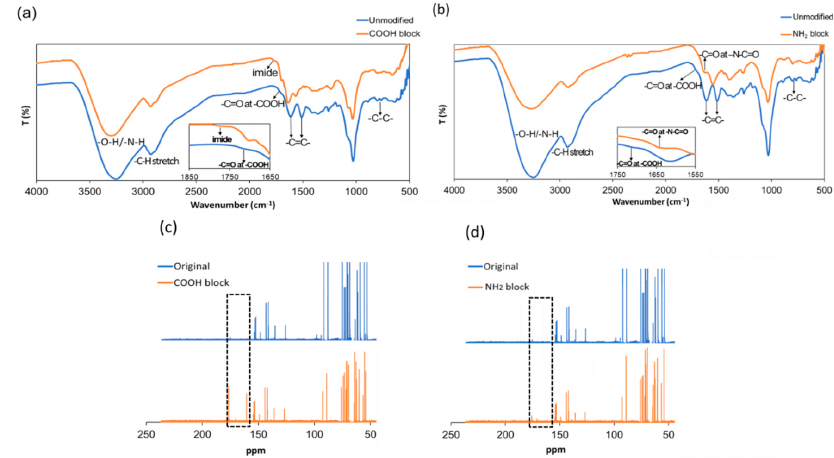
Figure 2. FTIR spectra comparison of the unmodified CNDs, –COOH-blocked CNDs ( a ), and –NH 2 - blocked CNDs ( b ) and 13 C NMR spectra comparison of the unmodified CNDs, –COOH-blocked CNDs ( c ), and –NH 2 -blocked CNDs ( d ). Each NMR spectrum is the average of 10,000